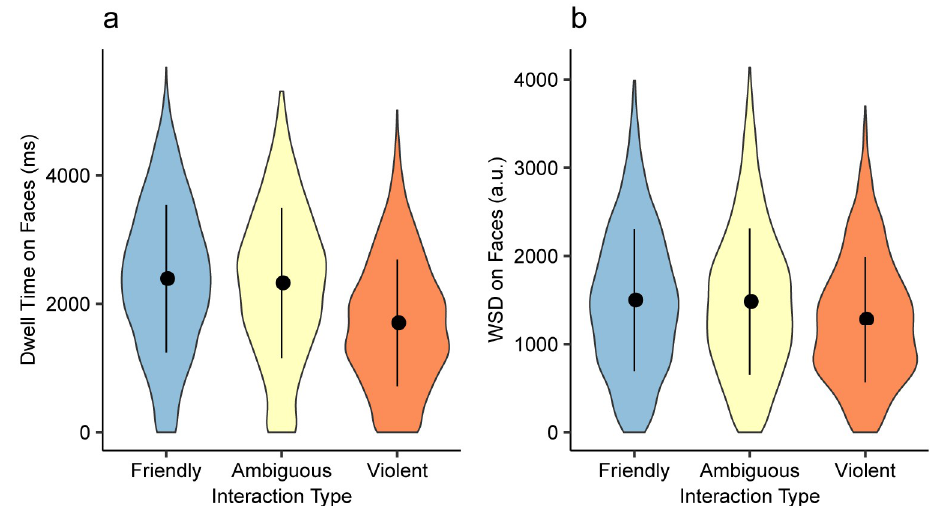
Fig 4. Fixation durations on faces by interaction type. a) AOI dwell time on Face AOIs by predefined interaction types. b) WSD on Face POIs by predefined interaction types. Error bars represent ± 1 SD. Although the values look similar, WSD and AOI dwell time uses different metrics and cannot be compared